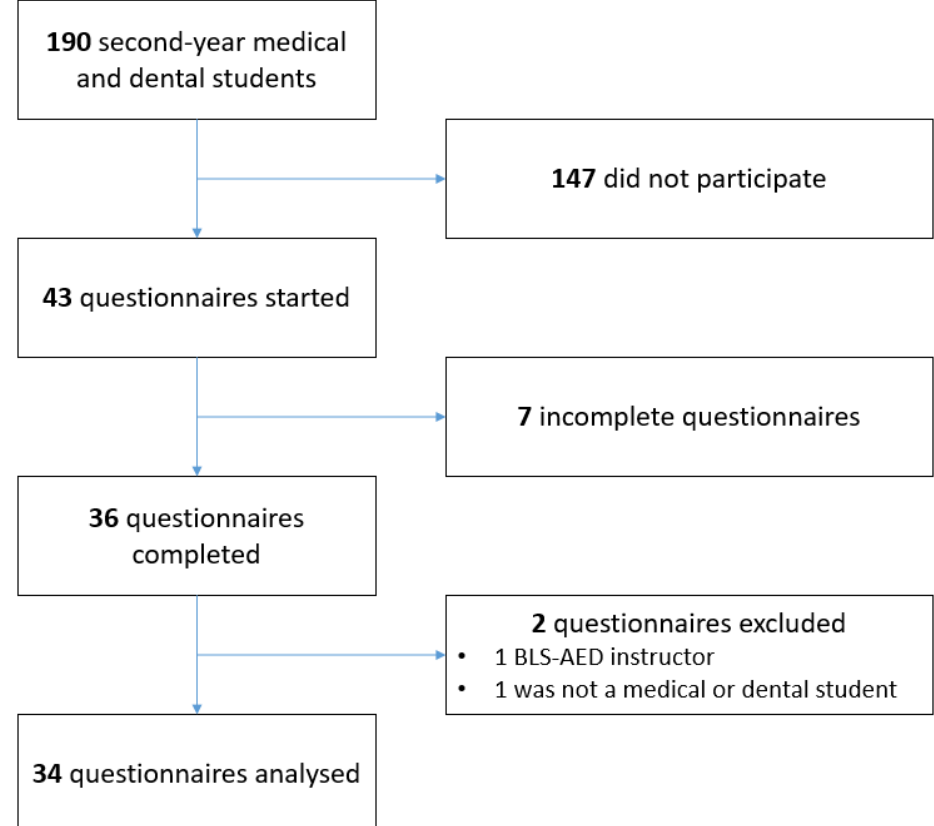
Figure 1. Flowchart of the inclusion of questionnaires completed by medical and dental students. The age of the participants was similar (22 ± 4 years old in 2020 vs. 21 ± 2, p = 0.08). Gender distribution was also similar ( p = 0.26).